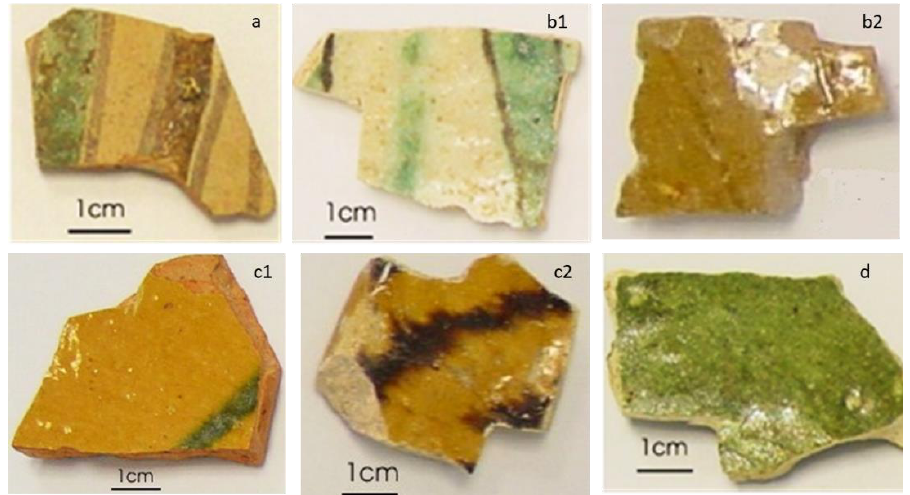
Figure 2. Ceramic fragments with different decorations found in Albarracin: ( a ) Cuerda seca ; ( b1 ) White tin-opacified glaze; ( b2 ) Yellow glaze on secondary-side of white-tin opacified ceramic; ( c1 ) Yellow/honey glaze with green line; ( c2 ) Yellow/honey glaze with brown line;( d ) Green glaze.